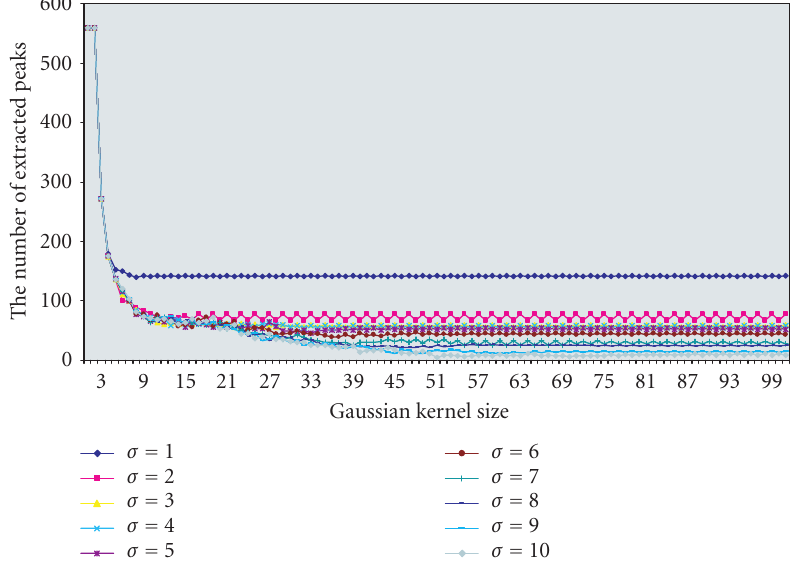
Figure 4.1. The e ff ect of Gaussian blurring on the extraction of peaks from the DEM of Great Basin.